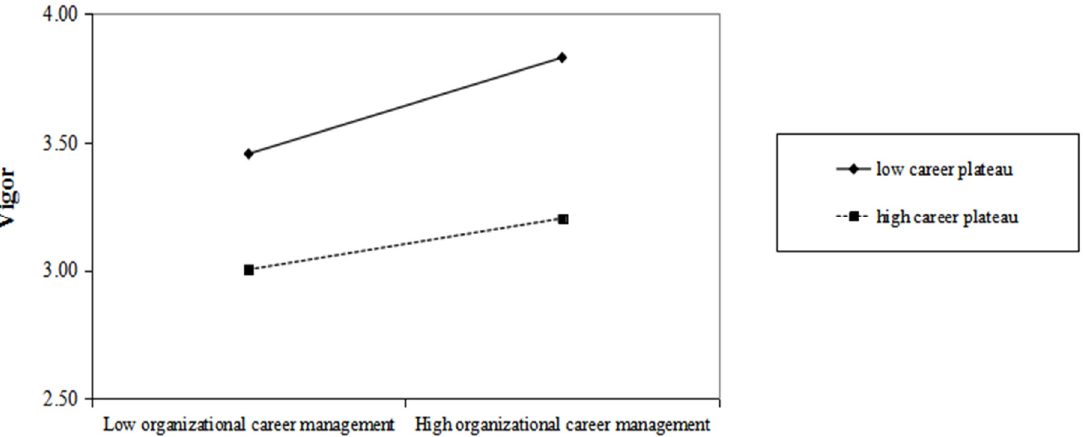
Figure 3. Moderating role of career plateau on organizational career management and employee vitality.